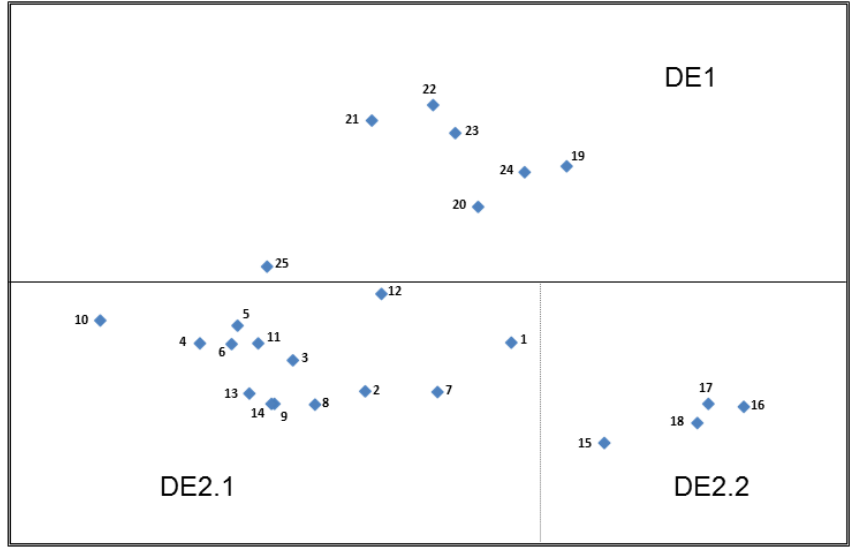
Figure 3. MSA Top Plot—Germany (DE). See Table 2 for the claims associated with the stimuli card